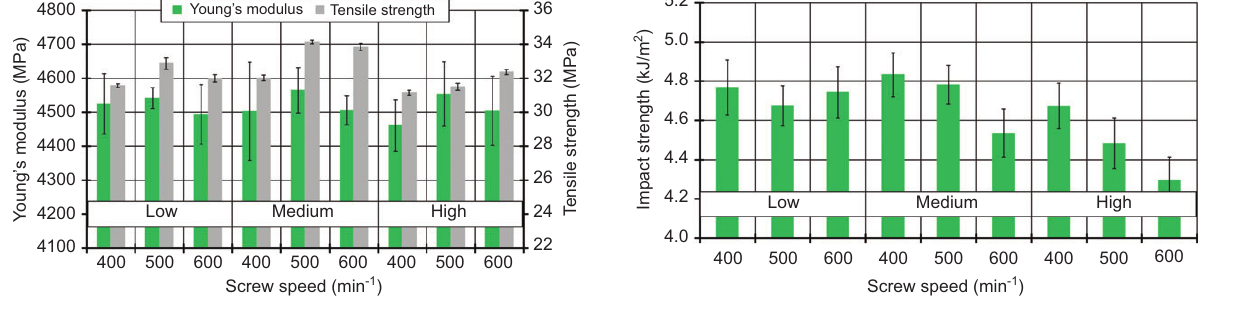
Figure 5 Young ’ s modulus and tensile strength for different screw configurations at 400 min -1 , 500 min -1 , and 600 min -1